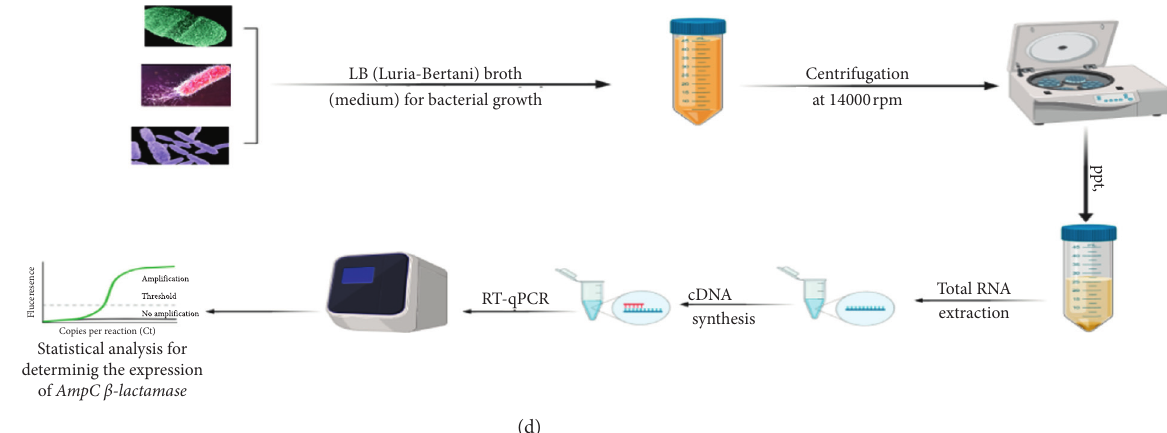
Figure 1: Flowchart of the followed methodology in this study, drawn by BioRender (https://biorender.com/). (a)Bacterial isolates and clinical samples. (b)Antimicrobial susceptibility testing. (c)Cefoxitin-cloxacillin double-disc synergy test (CC-DDS). (d)Quantification of AmpC β -lactamase encoding gene